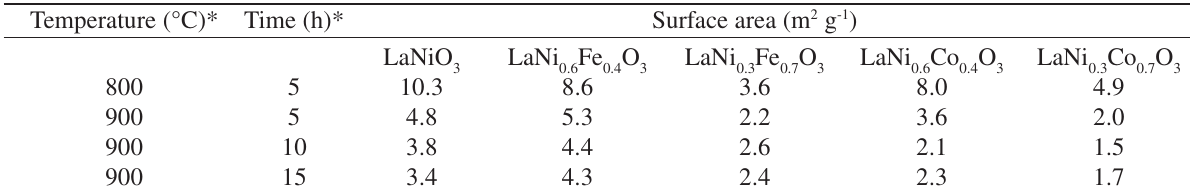
Fe O perovskite oxides. (1-x) x 3